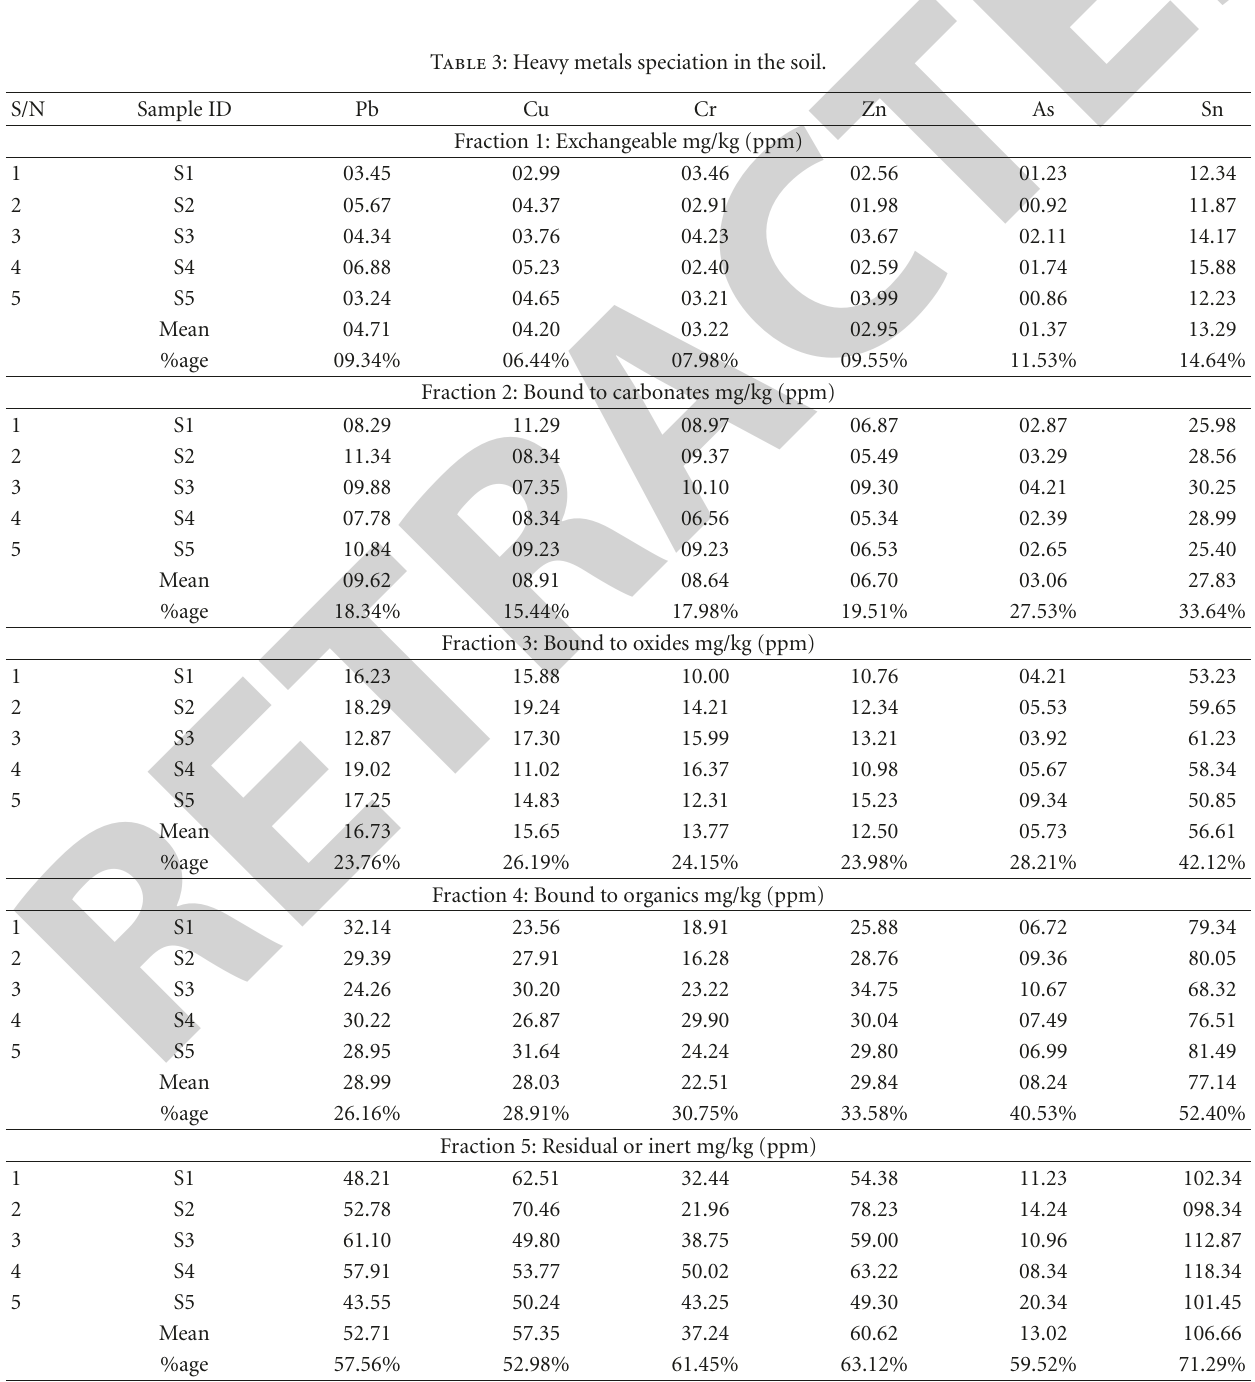
Table 3: Heavy metals speciation in the